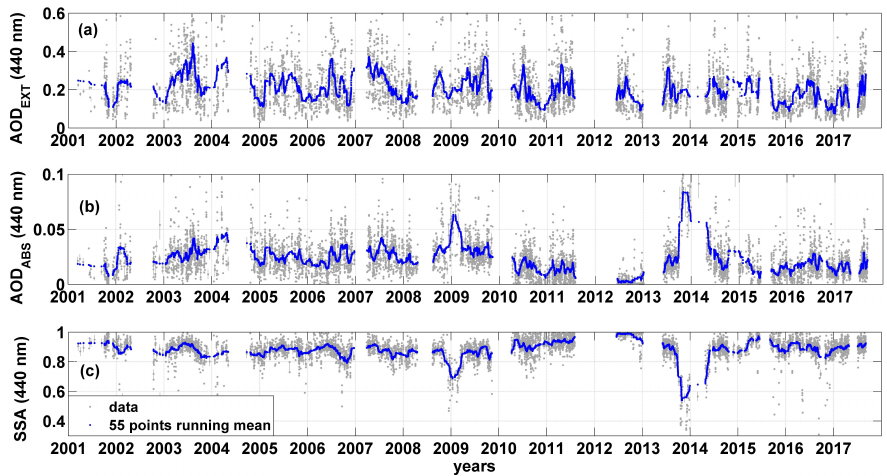
Figure 2. Time series of ( a ) AOD EXT , ( b ) AOD ABS , and ( c ) SSA retrieved from AERONET data, at the site of Rome Tor Vergata, from January 2001 to August 2017 (7697 data points). Grey markers show columnar measurements (measurement error bars are indicated by grey lines). Blue markers show the related (55 points) running mean. AERONET Version 2 Lev. 2.0* data inversion products are used (Section